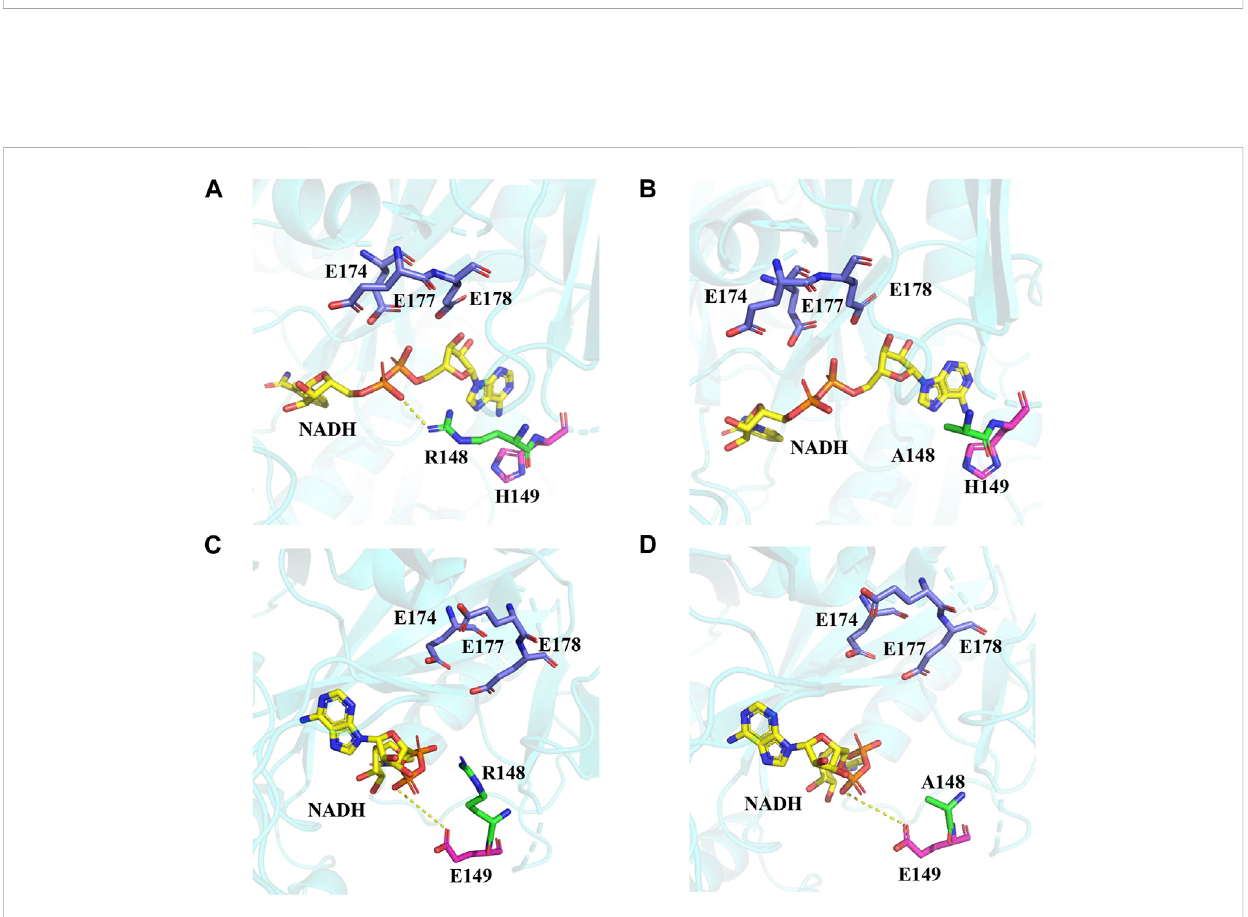
FIGURE 6 Structural analysis of the activity-related residues. (A) WT. (B) Mutant (R148A). (C) Mutant (H149E). (D) Mutant ( EcNudc-M ).